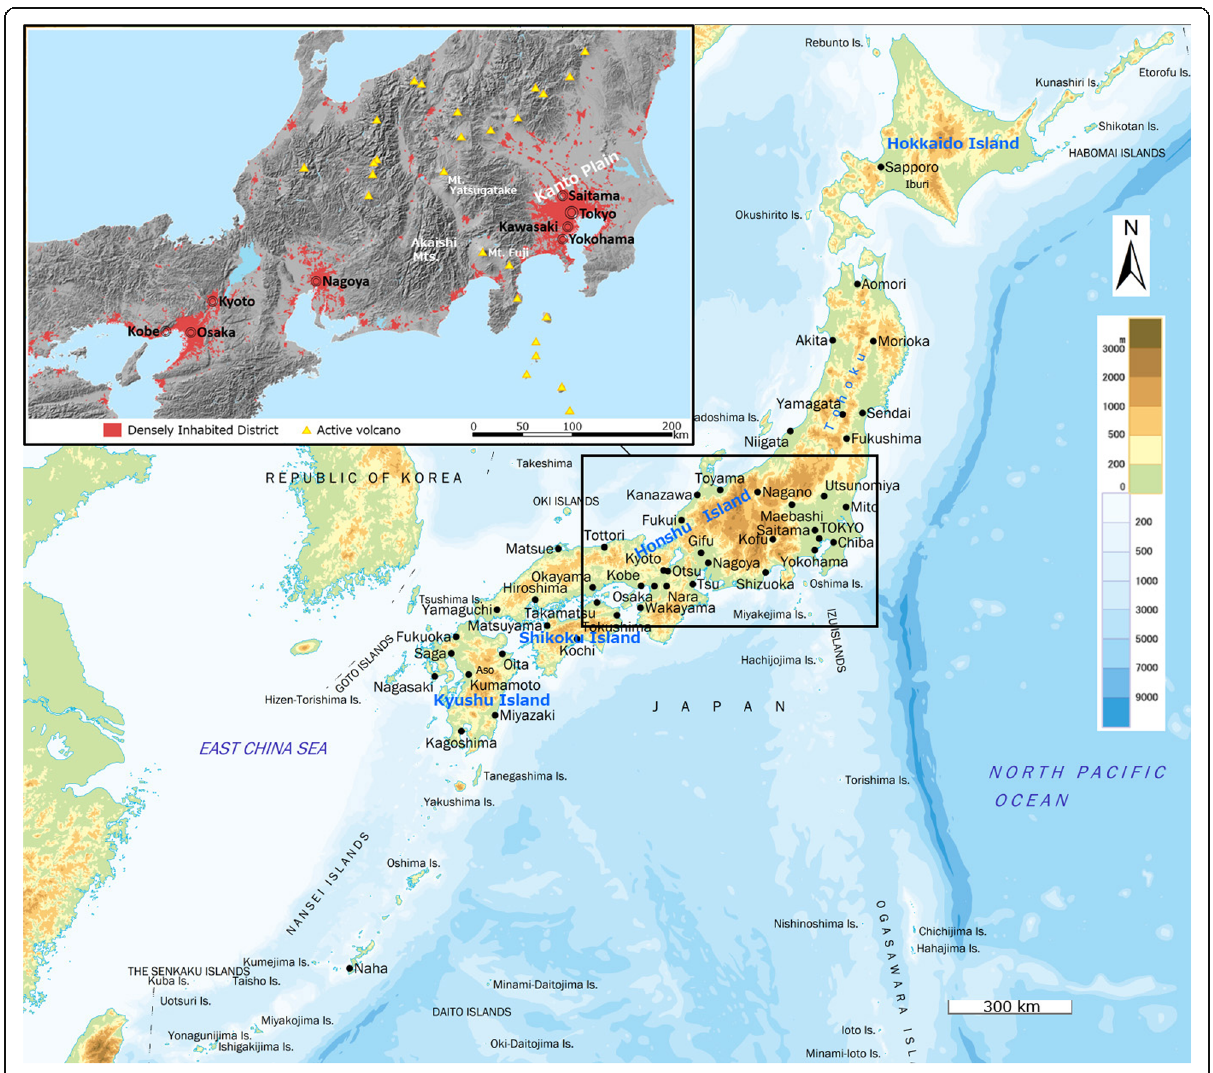
Fig. 5 Main islands of Japan and the central portion of Honshu Island. The shaded relief image of the central portion of Honshu Island (within the black framework) shows the locations of large cities, densely inhabited district (DID), and active